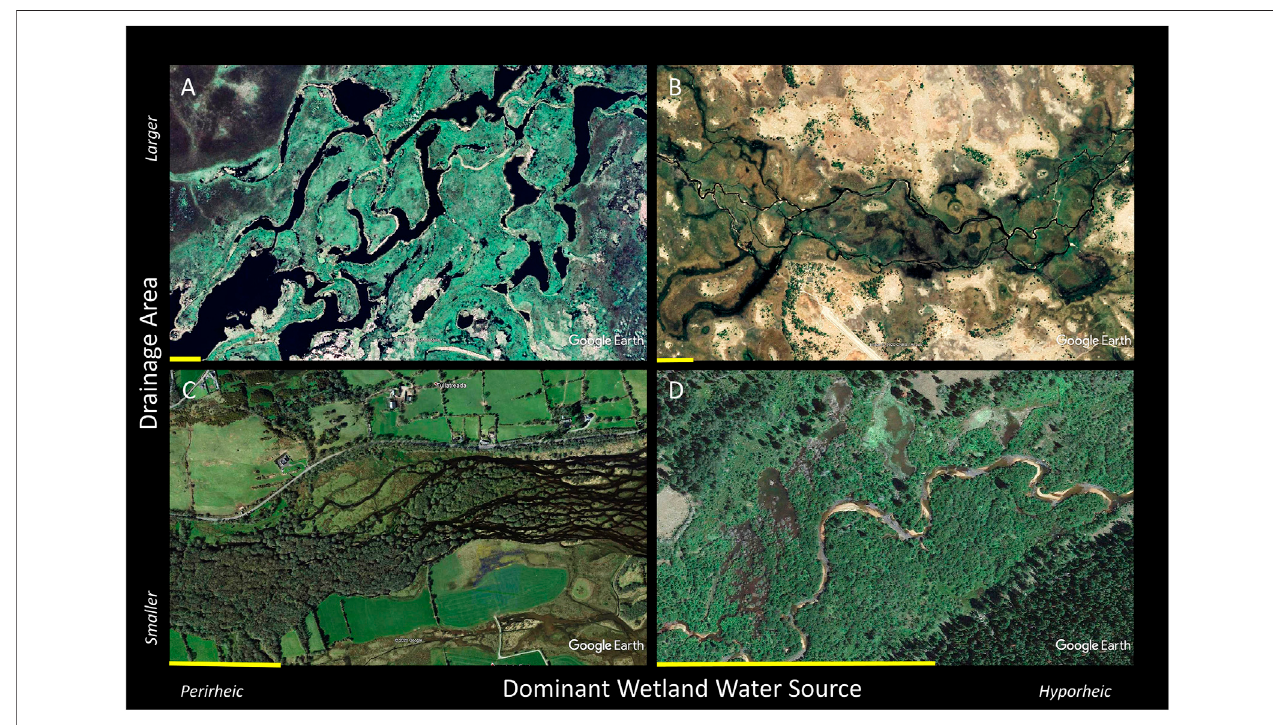
FIGURE 1 | Examples of “ contemporary remnants ” in which fully functional river-wetland corridors still exist: (A) Pantanal, River Paraguay, Brazil; (B) Okavango Delta,Okavango River, Botswana; (C) The Gearagh, River Lee, Ireland; (D) North St.VrainCreek, Colorado, United States. Each scale bar isapproximately 300 m long.